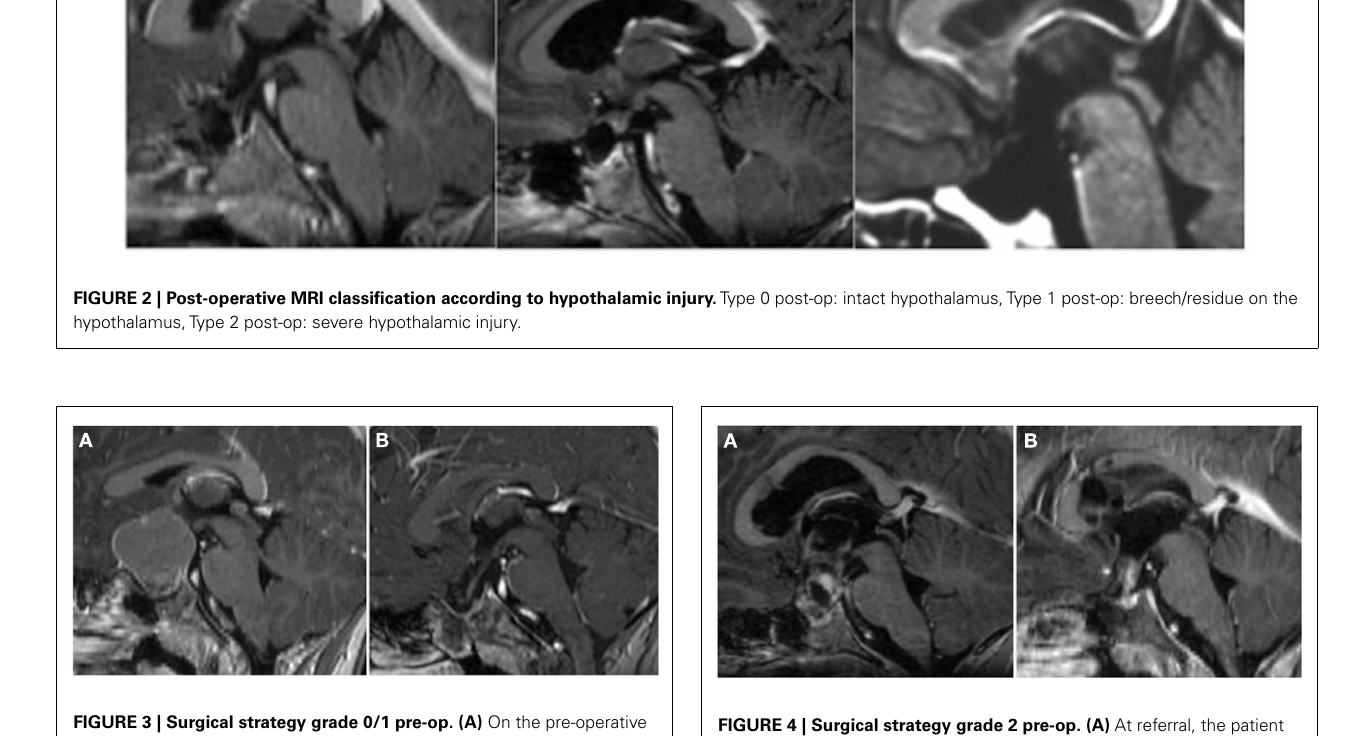
FIGURE 4 | Surgical strategy grade 2 pre-op. (A) At referral, the patient had severe intracranial hypertension secondary to obstructive hydrocephalus from a large intraventricular cyst of the third ventricle. An Ommaya reservoir was placed within the cyst as a matter of urgency.The tumor clearly invaded the hypothalamus (Type 2 pre-op) therefore the goal of surgery was to perform a subtotal removal leaving that component. (B) The residual lesion, attached to the infundibulum, which could not safely be